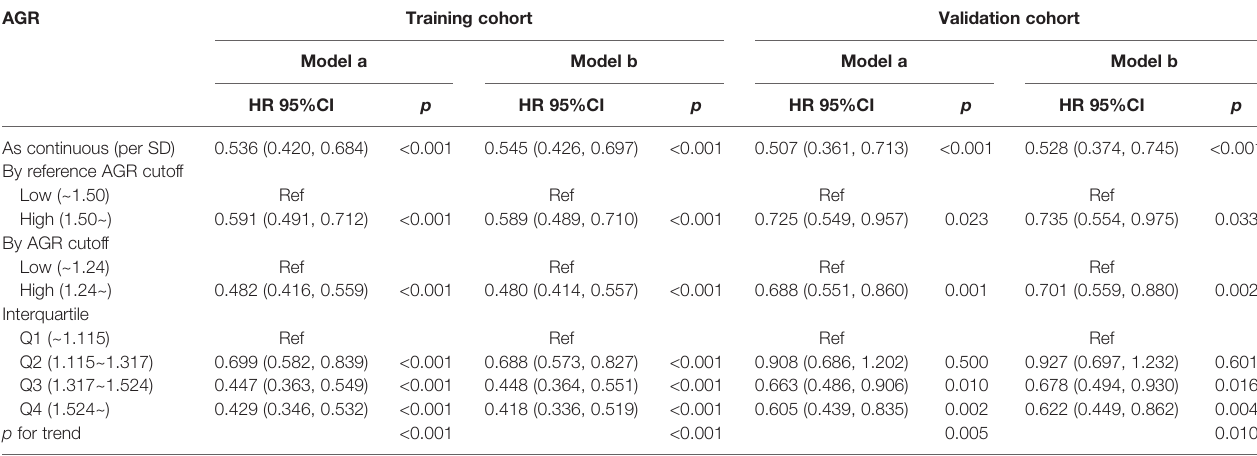
TABLE 3 | The association between AGR and hazard ratio of cachexia